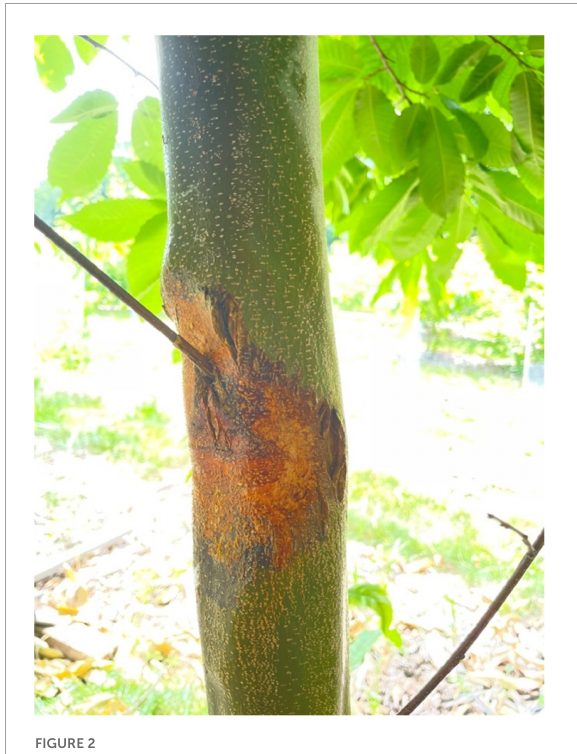
FIGURE2 Castanea dentata infected with Cryphonectria parasitica presenting an orange canker on the main trunk. This picture was taken at the Lafayette Experimental Road Station – SUNY-ESF (Syracuse, NY, United